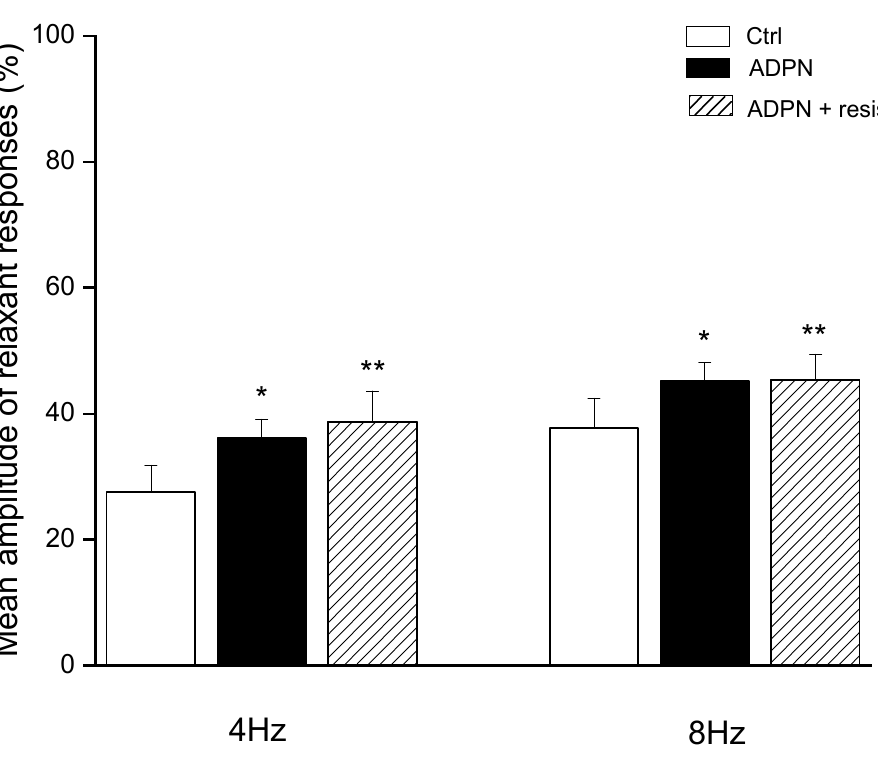
Figure 2. Mean amplitude of the EFS-induced relaxant responses in the presence of adiponectin (ADPN) and following the subsequent addition of resistin to the bath medium. Bar chart showing the significant increase in the mean amplitude of electrical field stimulation (EFS)-evoked relaxant responses at 4 and 8 Hz stimulation frequencies evoked by adiponectin (ADPN) (20 nM) and the lack of additional effects of resistin (60 ng/mL) added to the bath medium 30 min after ADPN. Amplitude values refer to the maximum peaks obtained during the stimulation period and represent percentage decreases relative to the muscular tension induced by carbachol (CCh, 1 µ M), taken as 100%. All values are means ± SEM of 4 strips. * p < 0.05 vs. its own control (Ctrl); ** p < 0.05 vs. its own Ctrl and p > 0.05 vs. ADPN (one-way ANOVA followed by Newman–Keuls post-test). Resistin (60 ng/mL) caused ( n = 4) a statistically significant increase in the mean amplitude of EFS-evoked relaxation ( p < 0.05) at both stimulation frequencies employed (Figure 3). The effects of the hormone were already detectable 15–20 min after its inclusion in the bath medium. The increase in the amplitude of the neurally-induced relaxant re- sponses caused by resistin appeared more pronounced, although not statistically different ( p > 0.05), compared to that evoked by ADPN at both stimulation frequencies employed (Figure 4). Thirty minutes after the addition of 60 ng/mL resistin to the bath medium, the inclusion of ADPN (20 nM) ( n = 4) did not cause any further significant increases ( p > 0.05) in the amplitude of the relaxant responses at either stimulation frequency employed (Figure